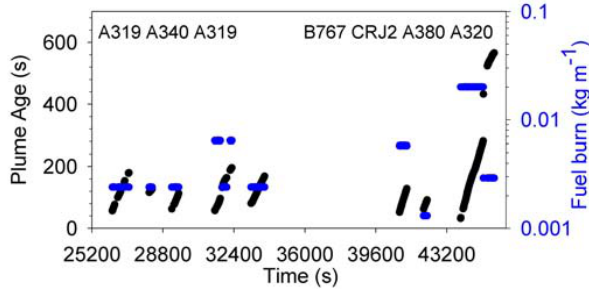
Fig. 7. Plume ages versus Falcon flight time and fuel consumption of the aircraft observed during two flights on 19 November 2008.